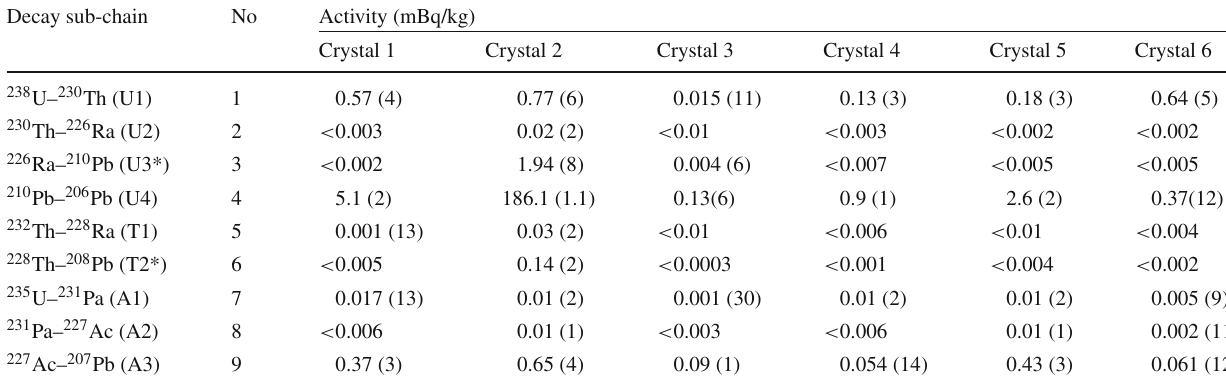
Table 4 Fitted activities of 232 Th, 235 U and 238 U sub-chains in the CMO crystal scintillators Decay sub-chain